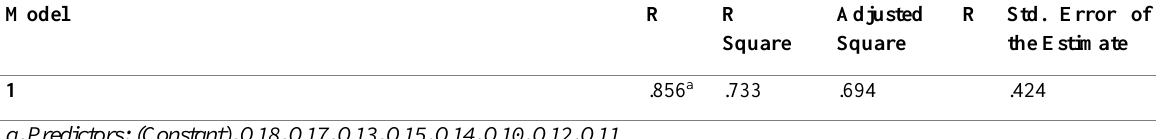
Table 2: Model Summary